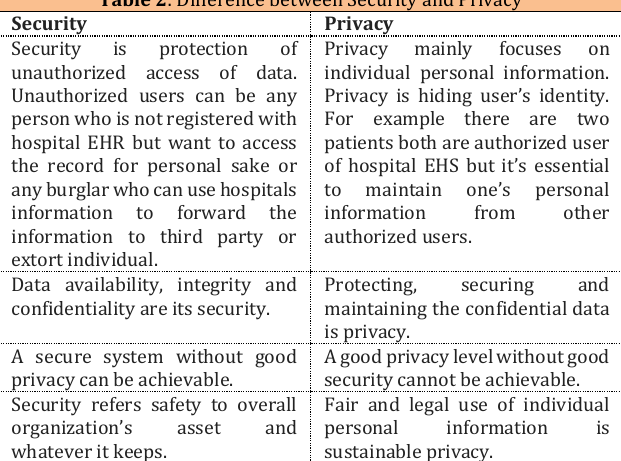
Table 2 : Difference between Security and Privacy